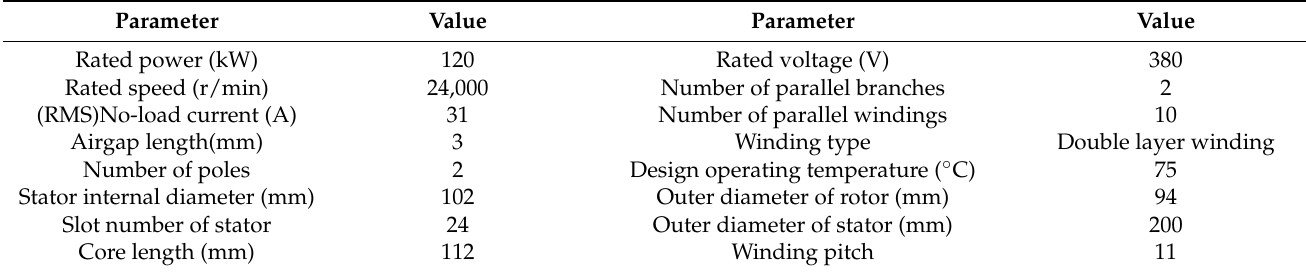
Table 1. The basic parameters of the high-speed permanent magnet motor.